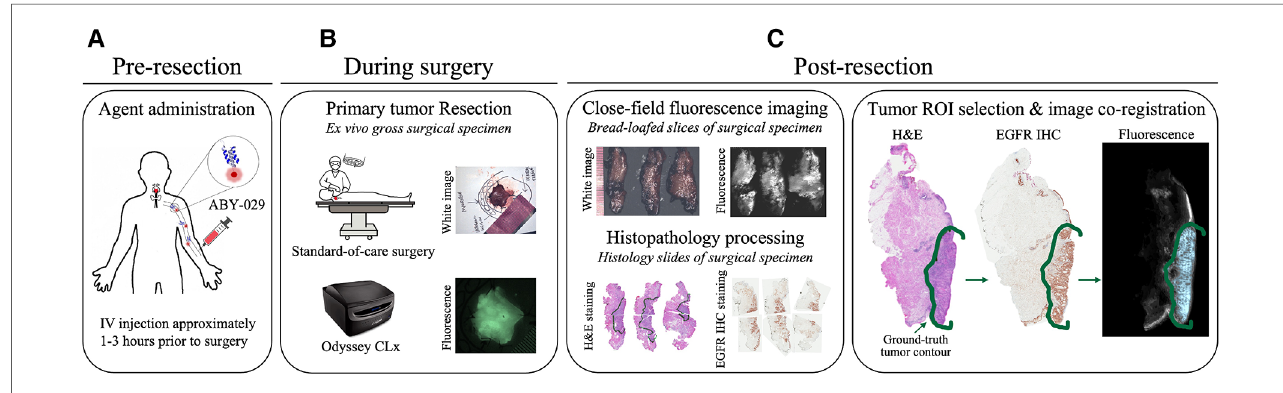
FIGURE 2 Clinical trial work fl ow. ( A ) ABY-029 was administered via 5 ml intravenous bolus injection 1 – 3 h prior to surgery. ( B ) Each patient underwent standard-of-care surgery, and gross surgical specimens were collected. ( C ) After surgery, specimens were sectioned in bread-loafed slices, formalin- fi xed, and paraf fi n- embedded, then cut into consecutive slides for staining. Closed- fi eld fl uorescence imaging was performed on the bread-loafed slices. Histology slides from bread-loafed slices underwent standard histopathological examination, providing tissue ROI ground